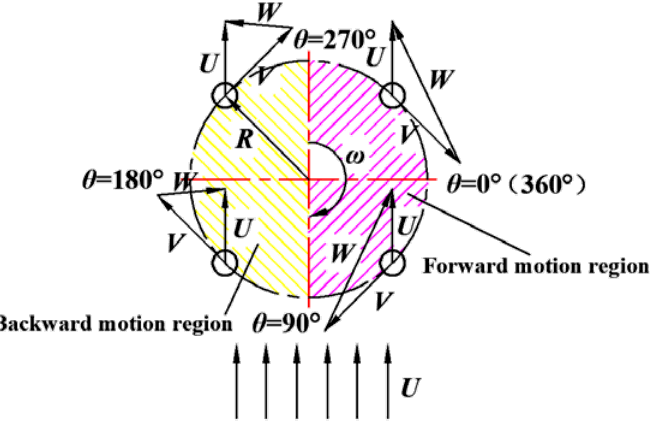
Figure 20. Schematic diagram of the relative positions of the cylinder and the incoming flow.